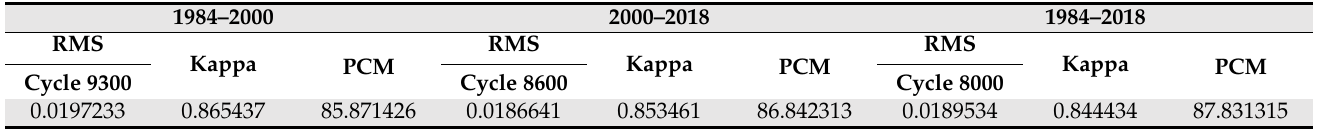
Table 8. Model validation results in ANN based on the LTM